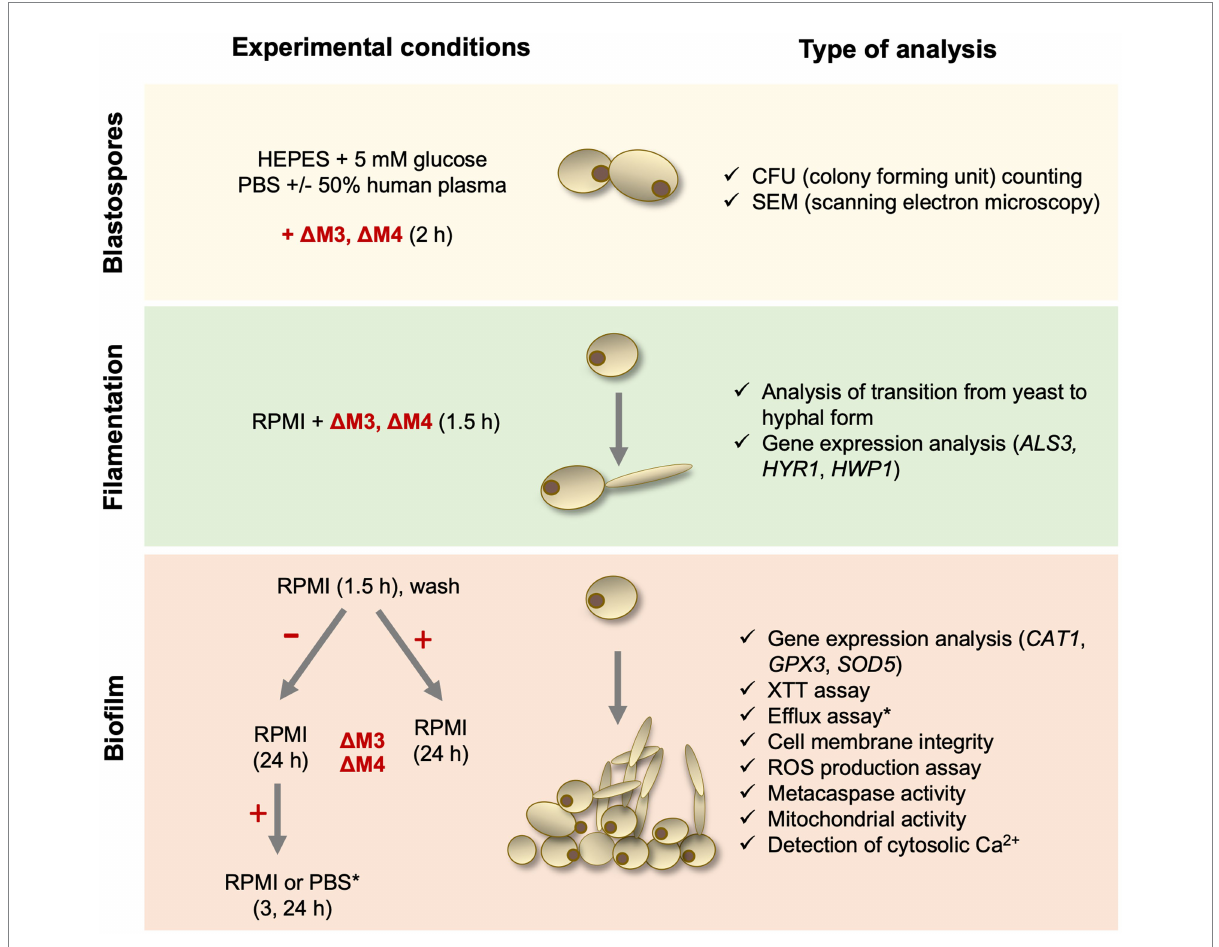
FIGURE 1 Diagram presenting experimental steps performed in this